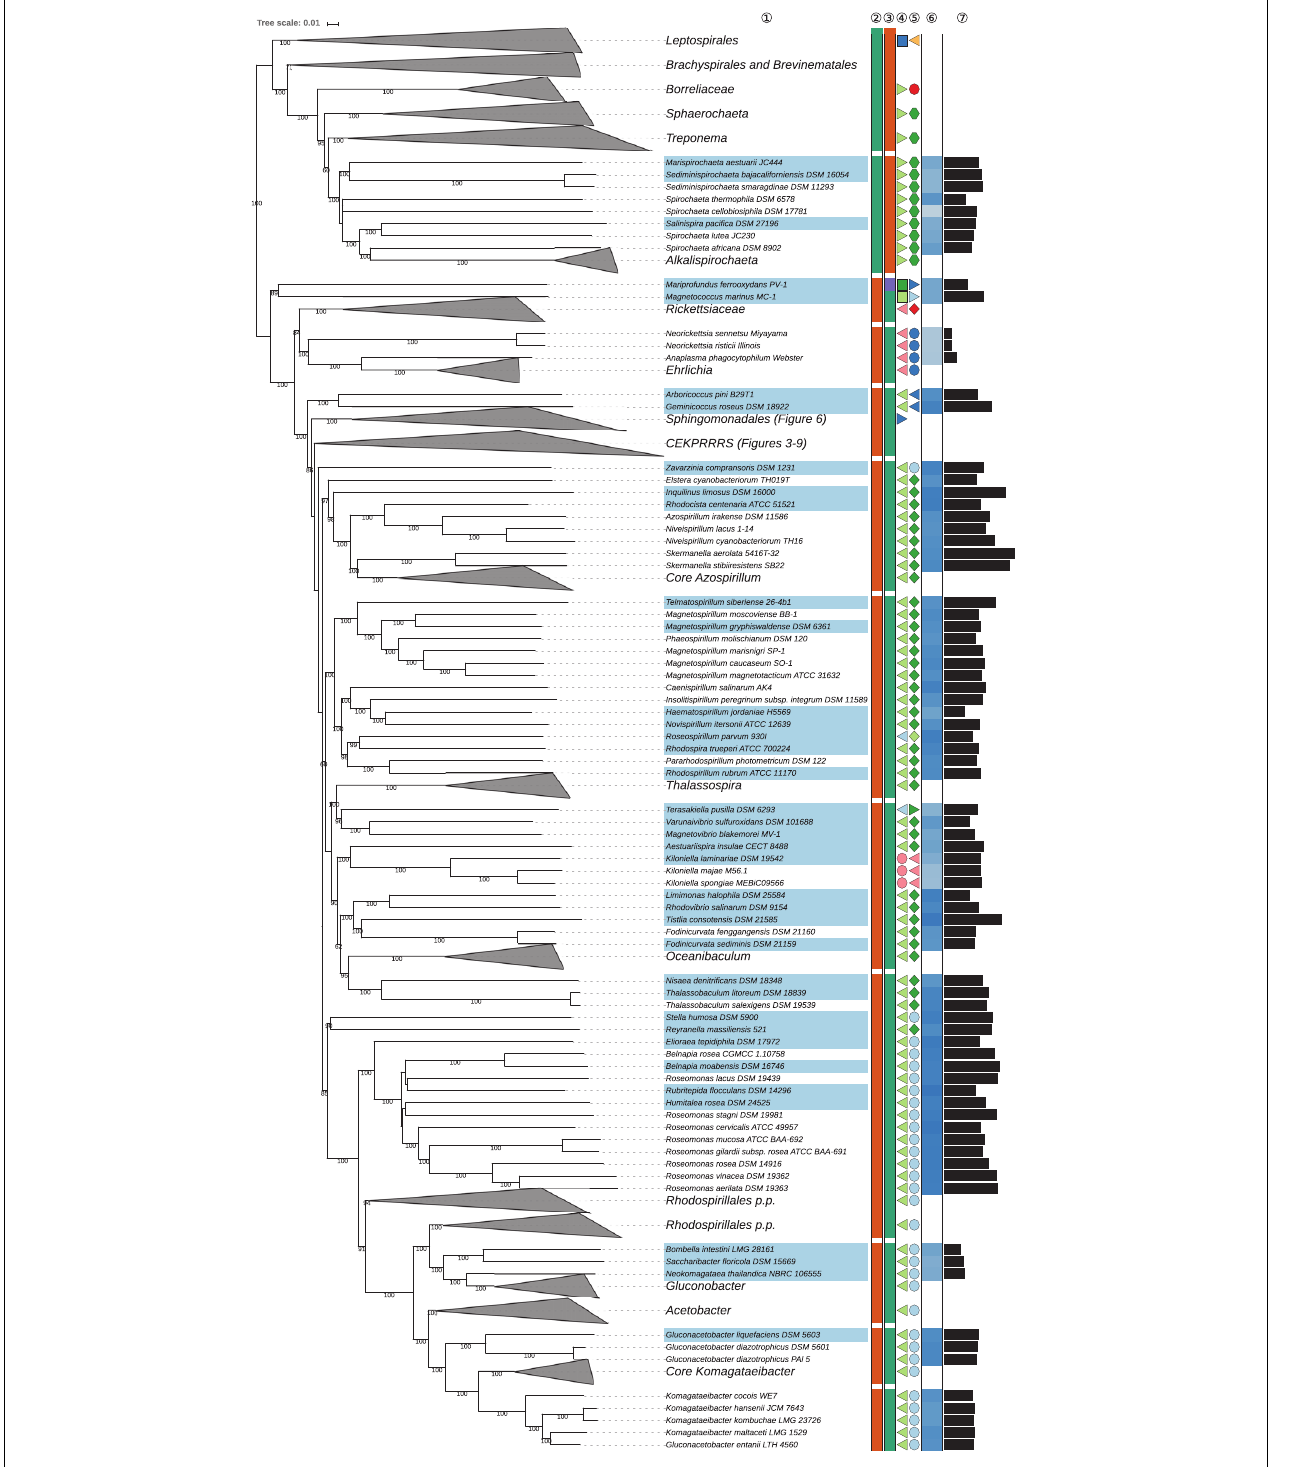
FIGURE 2 | First part of the GBDP tree shown in Figure 1 , focussing on the phylum Spirochaetes as well as Rhodospirillales, Rickettsiales and Kiloniellales within the class Alphaproteobacteria. The clade labeled CEKPRRRS comprises the orders Caulobacterales, Emcibacterales, Kordiimonadales, Parvularculales, Rhizobiales ( Hyphomicrobiales ) , Rhodobacterales, Rhodothalassiales, and Sneathiellales , details for which are shown in the subsequent figures. Tip labels with light-blue background indicate type species of genera, colors and symbols to the right of the tips indicate, from left to right, phylum, class, order, and family; for details and abbreviations see Figure 1 . The blue color gradient indicates the G+C content as calculated from the genome sequences, followed by black bars indicating the (approximate) genome size in base pairs.